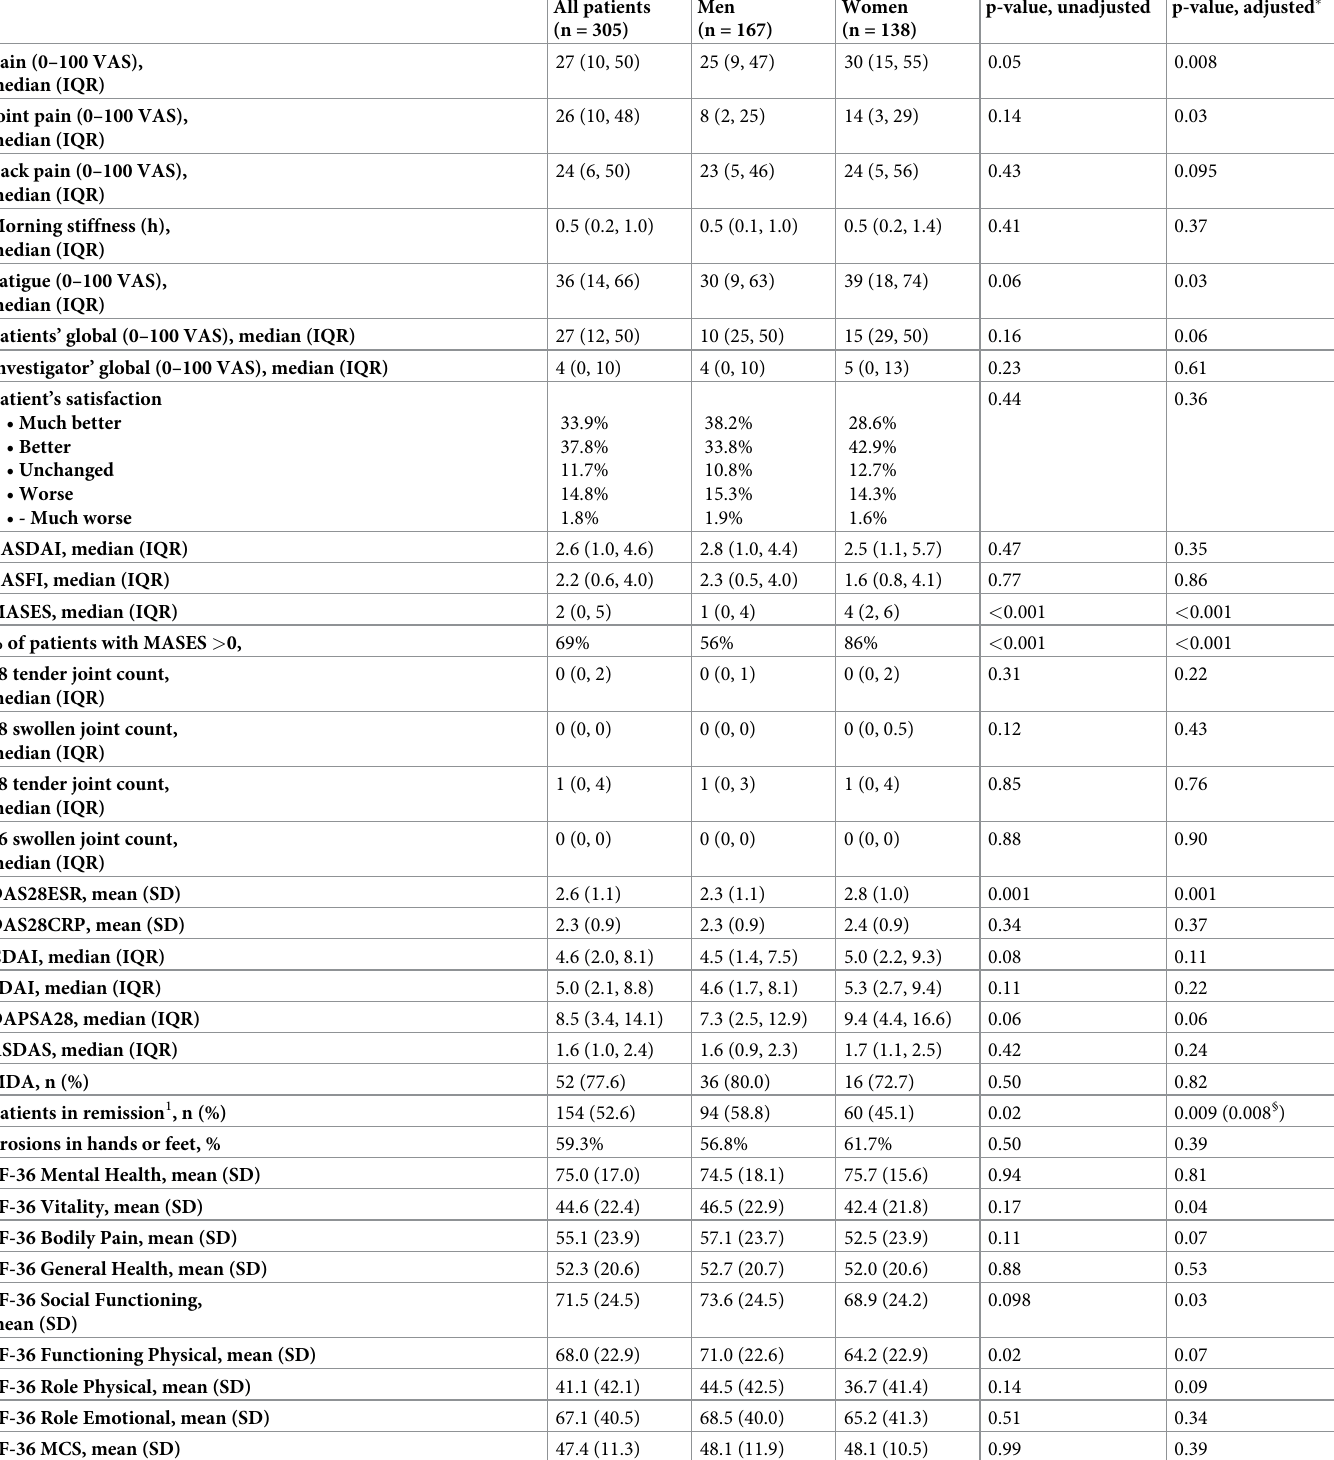
Table 2. Comparison of disease activity measures, physical functioning, health-related quality of life and laboratory markers between men and women with inflam- matory arthritis.